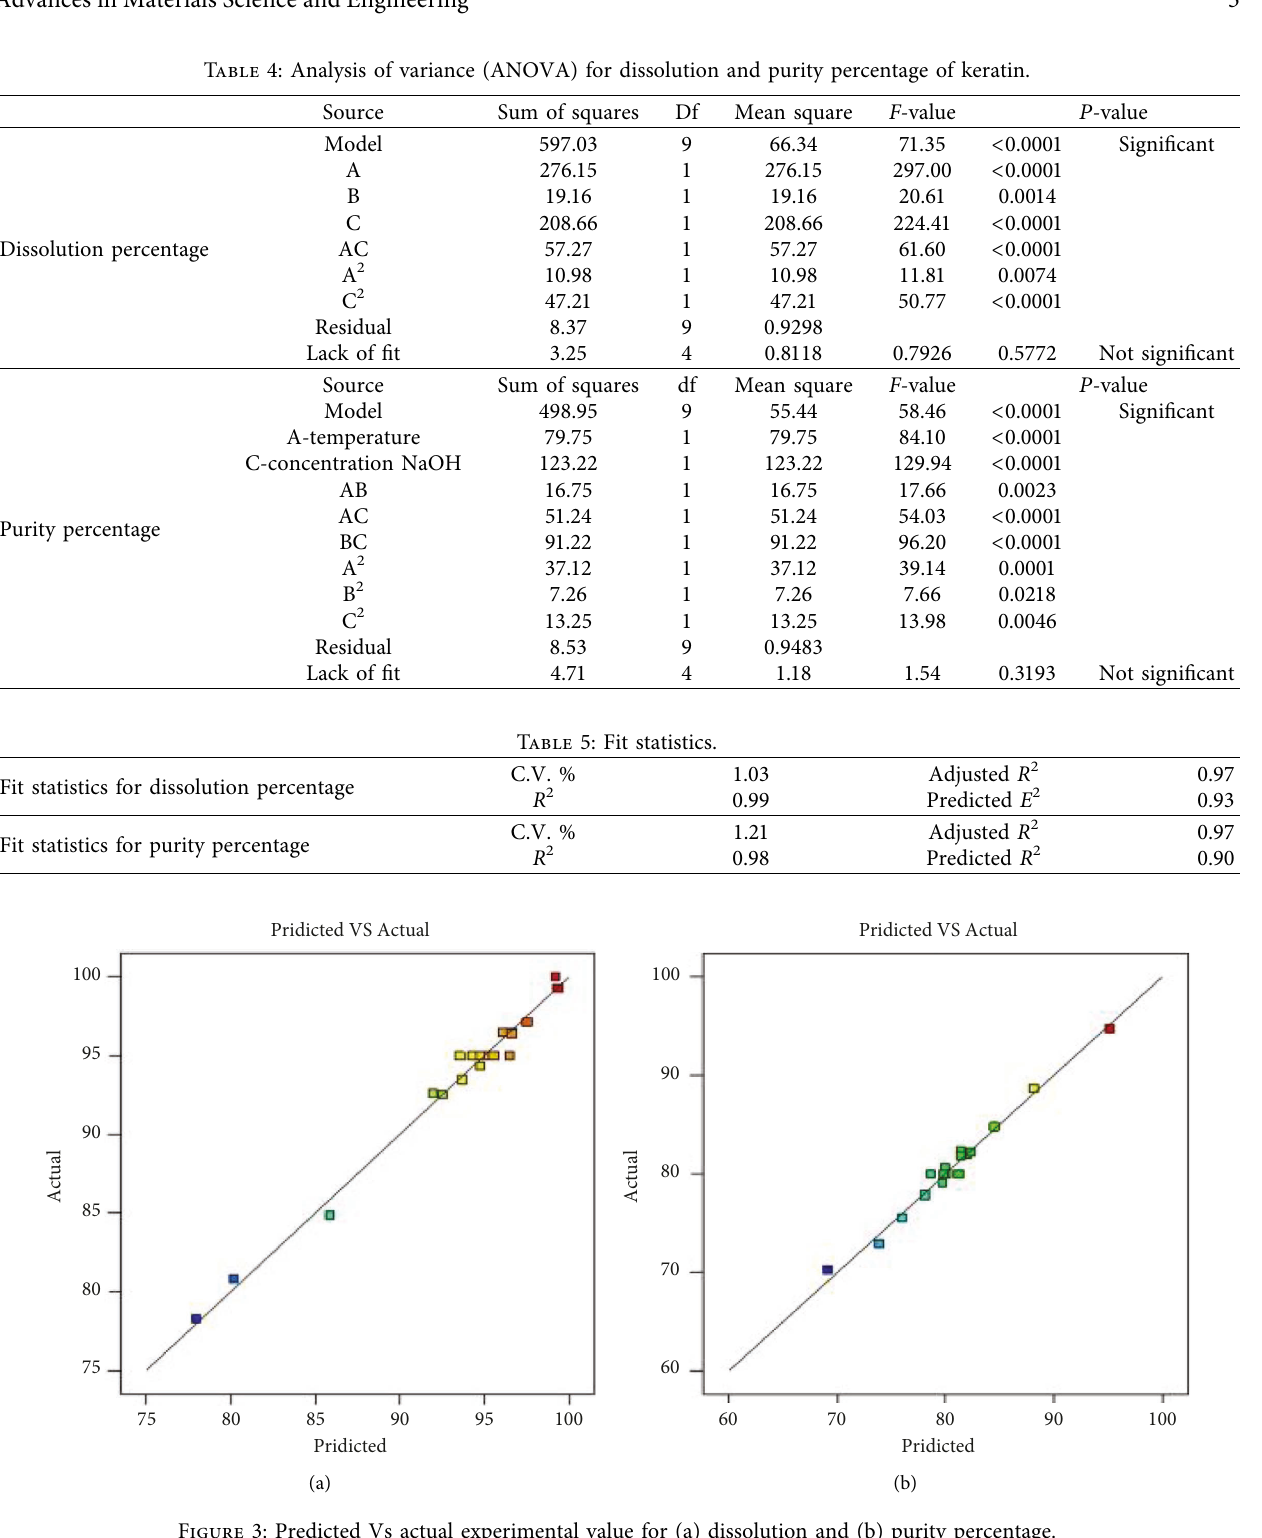
Figure 3: Predicted Vs actual experimental value for (a) dissolution and (b) purity